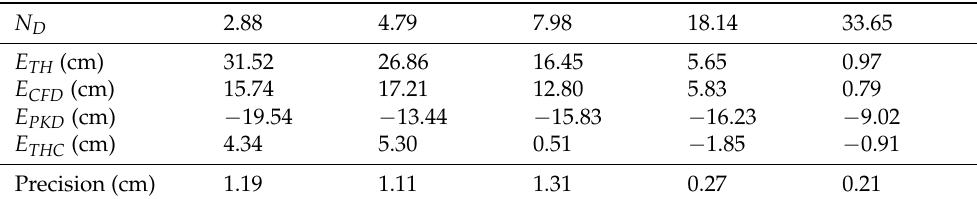
Figure 8. ( a ) Simulation and experiment results of detection probability versus mean number of fired pixels based on Equation (13). ( b ) N D derived from peak voltage and detection probability versus optical power. Table 1. Accuracy result and precision of different echo signal intensities with 100 repetitive measure- ments (part